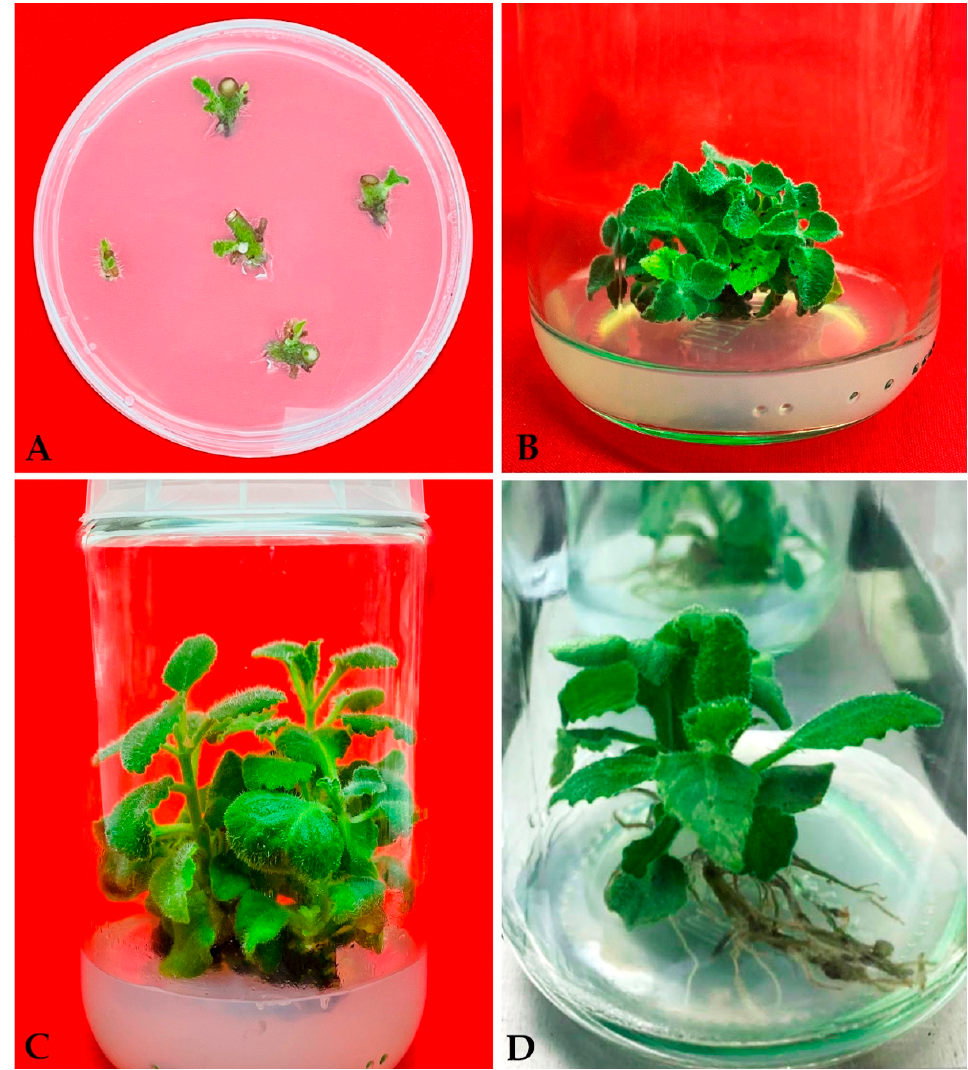
Figure 1. ( A ) Initiation of shoots from axillary node explants of Plectranthus amboinicus . ( B ) Multiple shootlets of P. amboinicus after 4 weeks of culture. ( C ) Proliferated multiple shoots of P. amboinicus after 8 weeks of culture. ( D ) Rooted P. amboinicus shoot after 4 weeks of transfer on the rooting media.